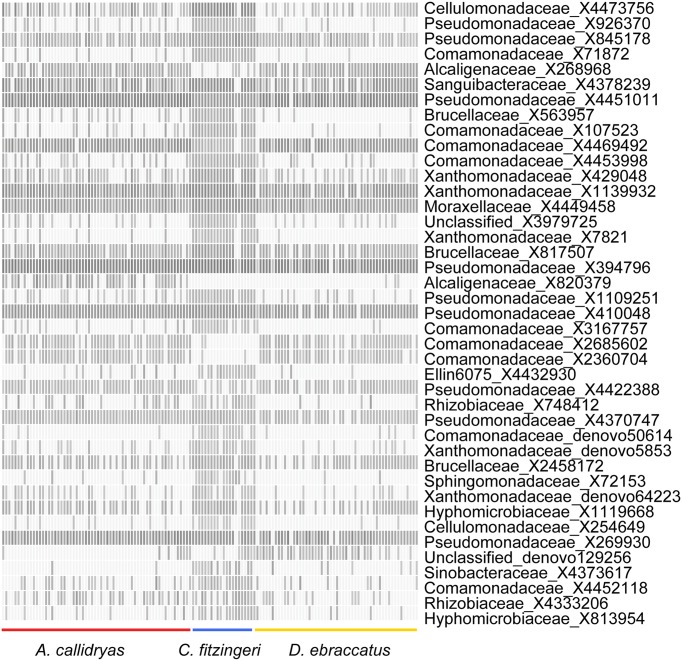
Relative abundance of 41 OTUs selected based on K-S measures that best defined the differences in skin bacterial community structure of three frog species from Panamá (left, Agalychnis callidryas; right, Dendropsophus ebraccatus; center, Craugastor fitzingeri). OTU relative abundances ranged from 0 to 0.32. Lighter shades indicate lower relative abundances (white relative abundance = 0) and darker shades indicate higher relative abundances (darkest relative abundance = 0.32). OTUs are ordered top to bottom based on K-S measures (see Table 2 for exact values and additional taxonomic information for each OTU).